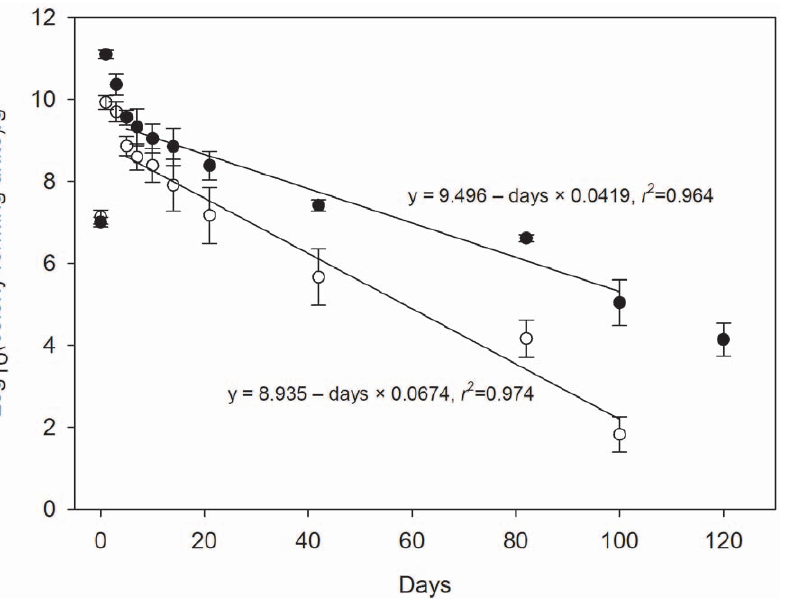
Figure 3. Ceftiofur metabolites select for ceftiofur resistant E.coli in soil. Mean colony forming units for cef R E. coli after incubation at 23 u C in a sandy soil and urine matrix (open circles, 0 ppm CFM; closed circles 50 ppm CFM). Regression lines between days 5 and 100 were significantly